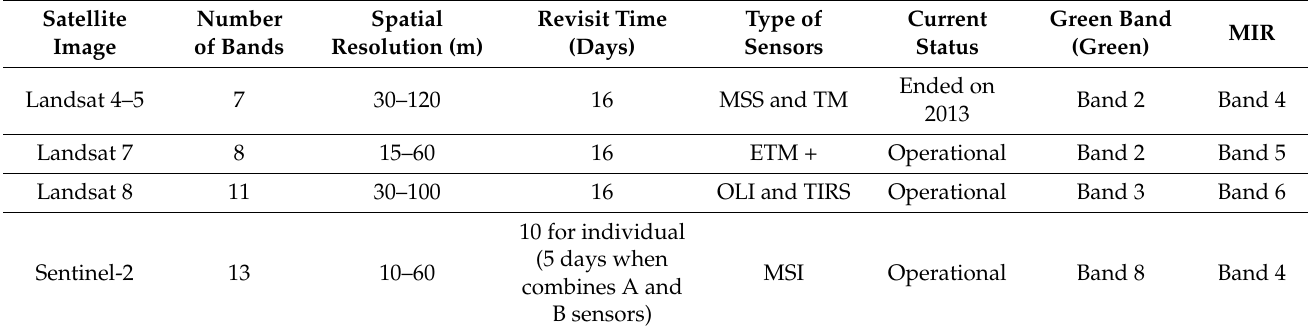
Table 1. Satellite image attributes [26] and spectral bands applied for computing